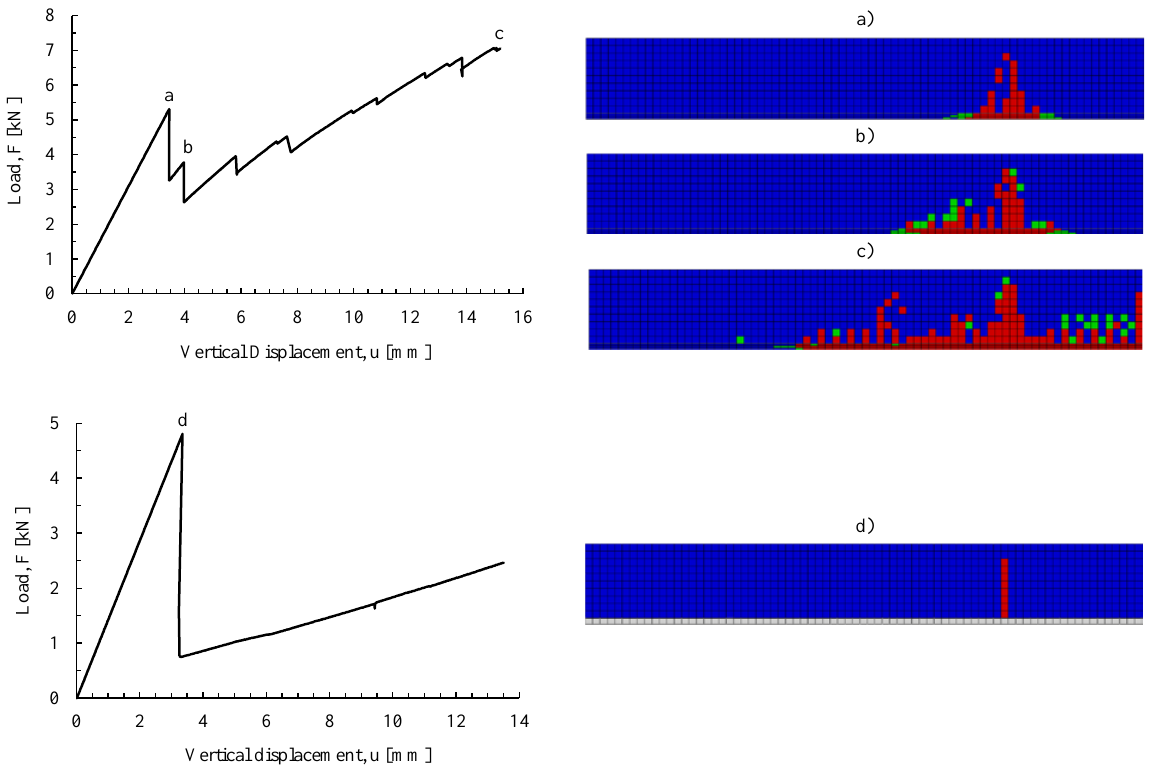
Fig. 5 Load vs . vertical displacement diagrams of the S Dur (top left side) and S Flex (bottom left side) beams, obtained from the ABAQUS using a damaged plasticity model, as well as the crack pattern a), b), c) and d) at different phases (right side). The load vs . vertical displacement diagrams obtained by using distinct models are plotted and compared in the Fig. 6 for the composite beams made with epoxy (S Dur ) and polyurethane (S Flex ) adhesives. Table 2 presents, for the simulated beams, the main parameters characterizing its structural behaviour: elastic stiffness, K el , cracking load, F ck , and corresponding vertical displacement, u ck .